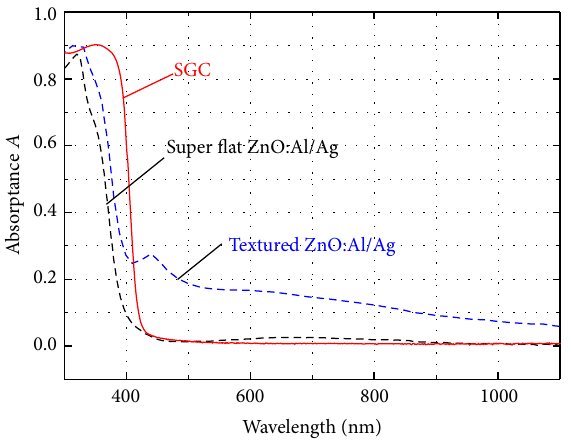
Figure 4: Absorptance ( 𝐴 = 1−𝑅 ) of three different back reflectors: textured ZnO:Al/Ag (blue dashed line), super flat ZnO:Al/Ag back reflector (black dash line), and Snow Globe Coating back reflector (red solid